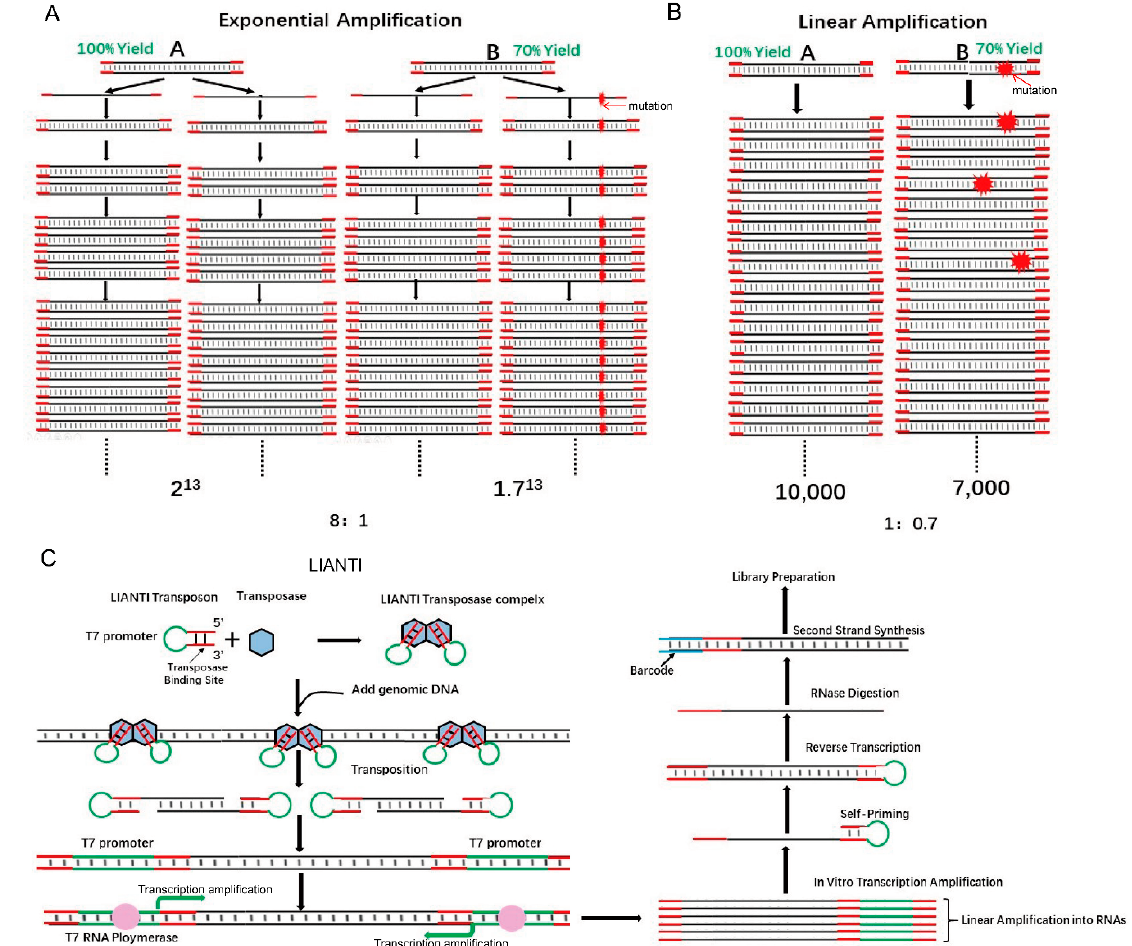
Figure 3. Tn5 is used in the study single-cell genomic variations. ( A ). Exponential amplification results in bias and errors. The replication yields of DNA fragments A and B are 100% and 70%, respectively. For a final copy number of approximately 10,000, the final ratio of fragments A/B for exponential amplification is 8:1 [22]. ( B ). Linear amplification significantly reduces bias and errors. The replication yields of DNA fragments A and B are 100% and 70%, respectively. For a final copy number of approximately 10,000, the final ratio of fragments A/B for linear amplification is 1:0.7 [22]. ( C ). The